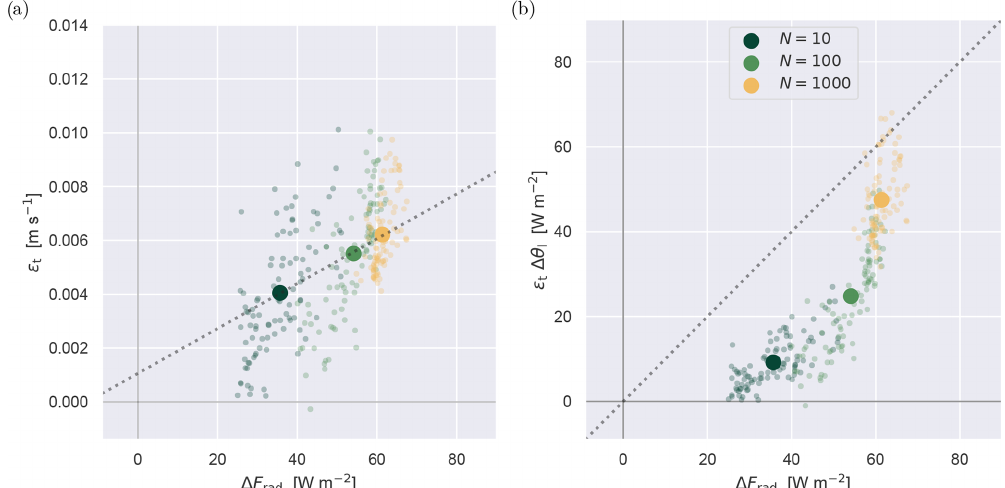
Figure 16. Scatter plots of terms in the radiative entrainment efficiency α , as defined by Eq. (3). The net longwave flux difference across the cloud layer (cid:49)F rad is plotted against (a) the top entrainment rate (cid:15) t and (b) the entrainment flux (cid:15) t (cid:49)θ l in energy units. Diagnostics at 2h − 1 frequency are shown as small semi-transparent dots, while the 48h mean is shown as an opaque big dot. In panel (a) the dotted line represents the linear fit through the means, while in panel (b) it represents the line at which α = 1.